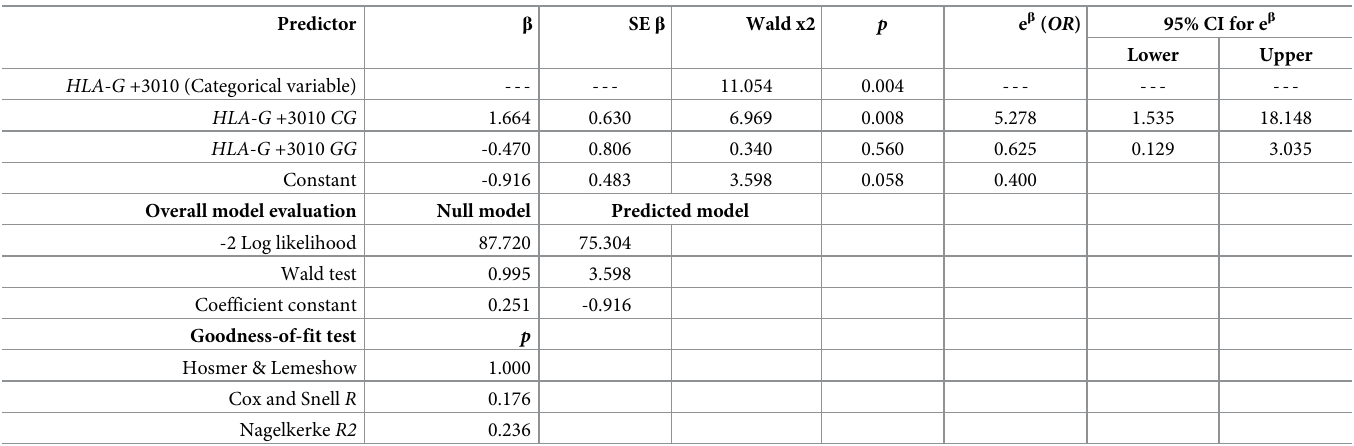
Table 4. Logistic regression analysis of kidney-transplant patients for rejection.